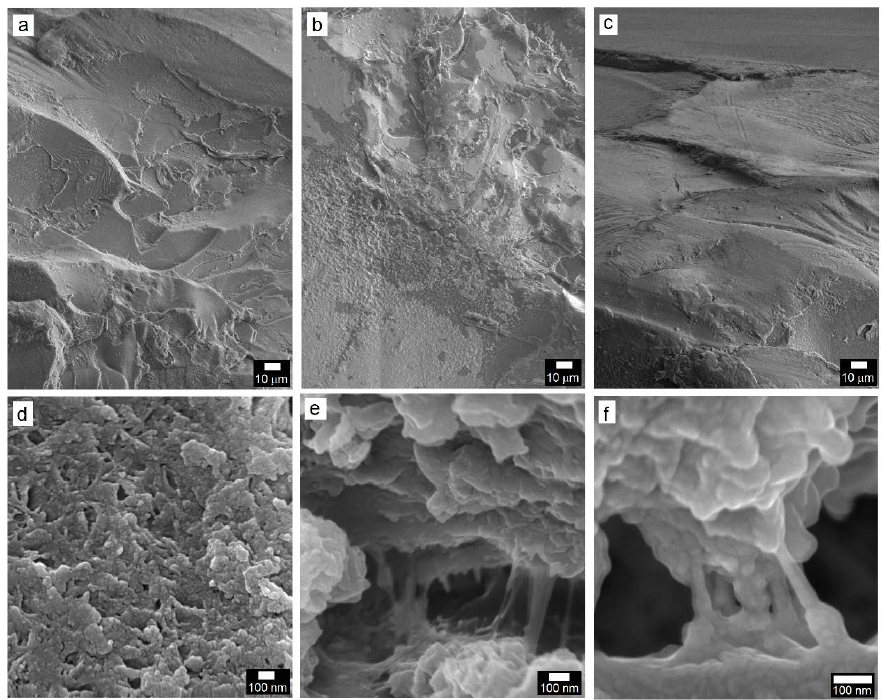
Figure 11. SEM microstructures of the fractured PC/TiO 2 -0.5HN composite: ( a , b ) Near-surface region revealing craze formation and matrix degradation during the DOP test; ( c ) highly smooth region polymer matrix degradation and flow in the presence of DOP and localized stress; ( c ) large, smooth region near the back surface of the test specimen; ( d ) rough, voided region characteristic of high resistance to crack propagation; ( e , f ) within crack segments showing crack bridging by the TiO 2 nanosheets and